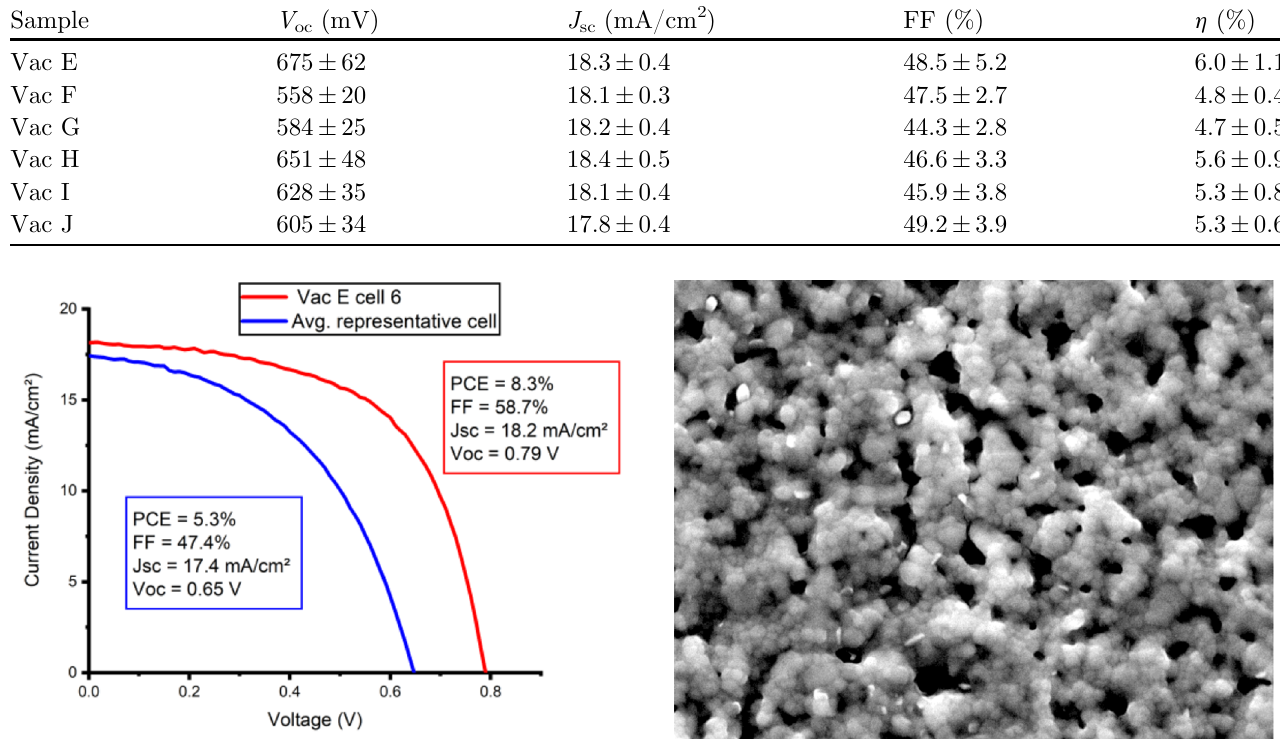
Fig. 5. J – V curves of champion and average-representative cells obtained with vacuum quenching. For the average-representative cell, the one with closest performance to the average values was chosen.